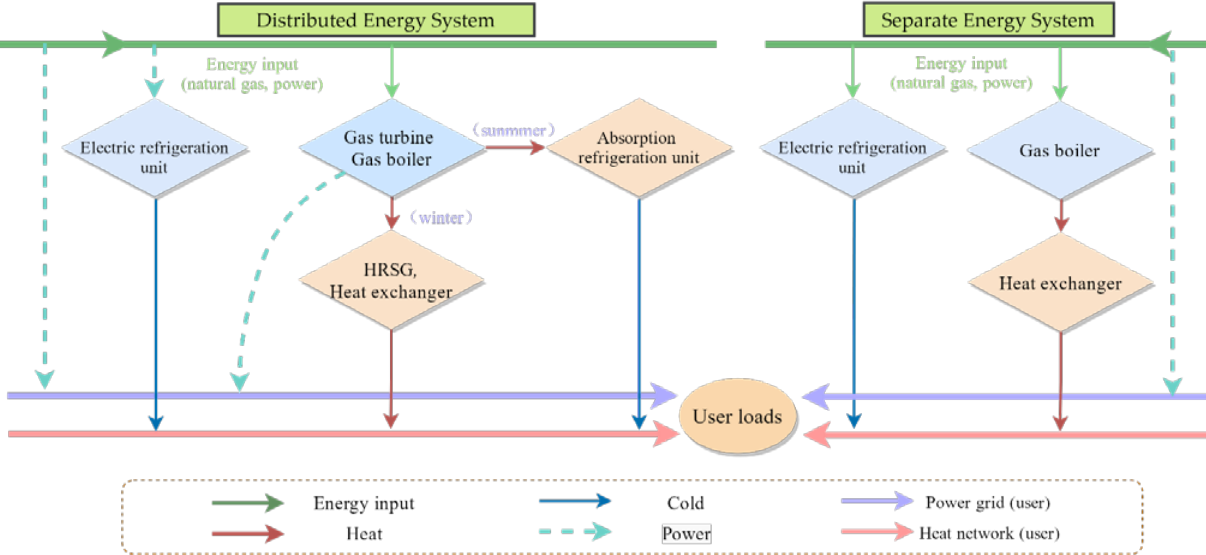
Figure 1. The typical structure of the DES and SP.